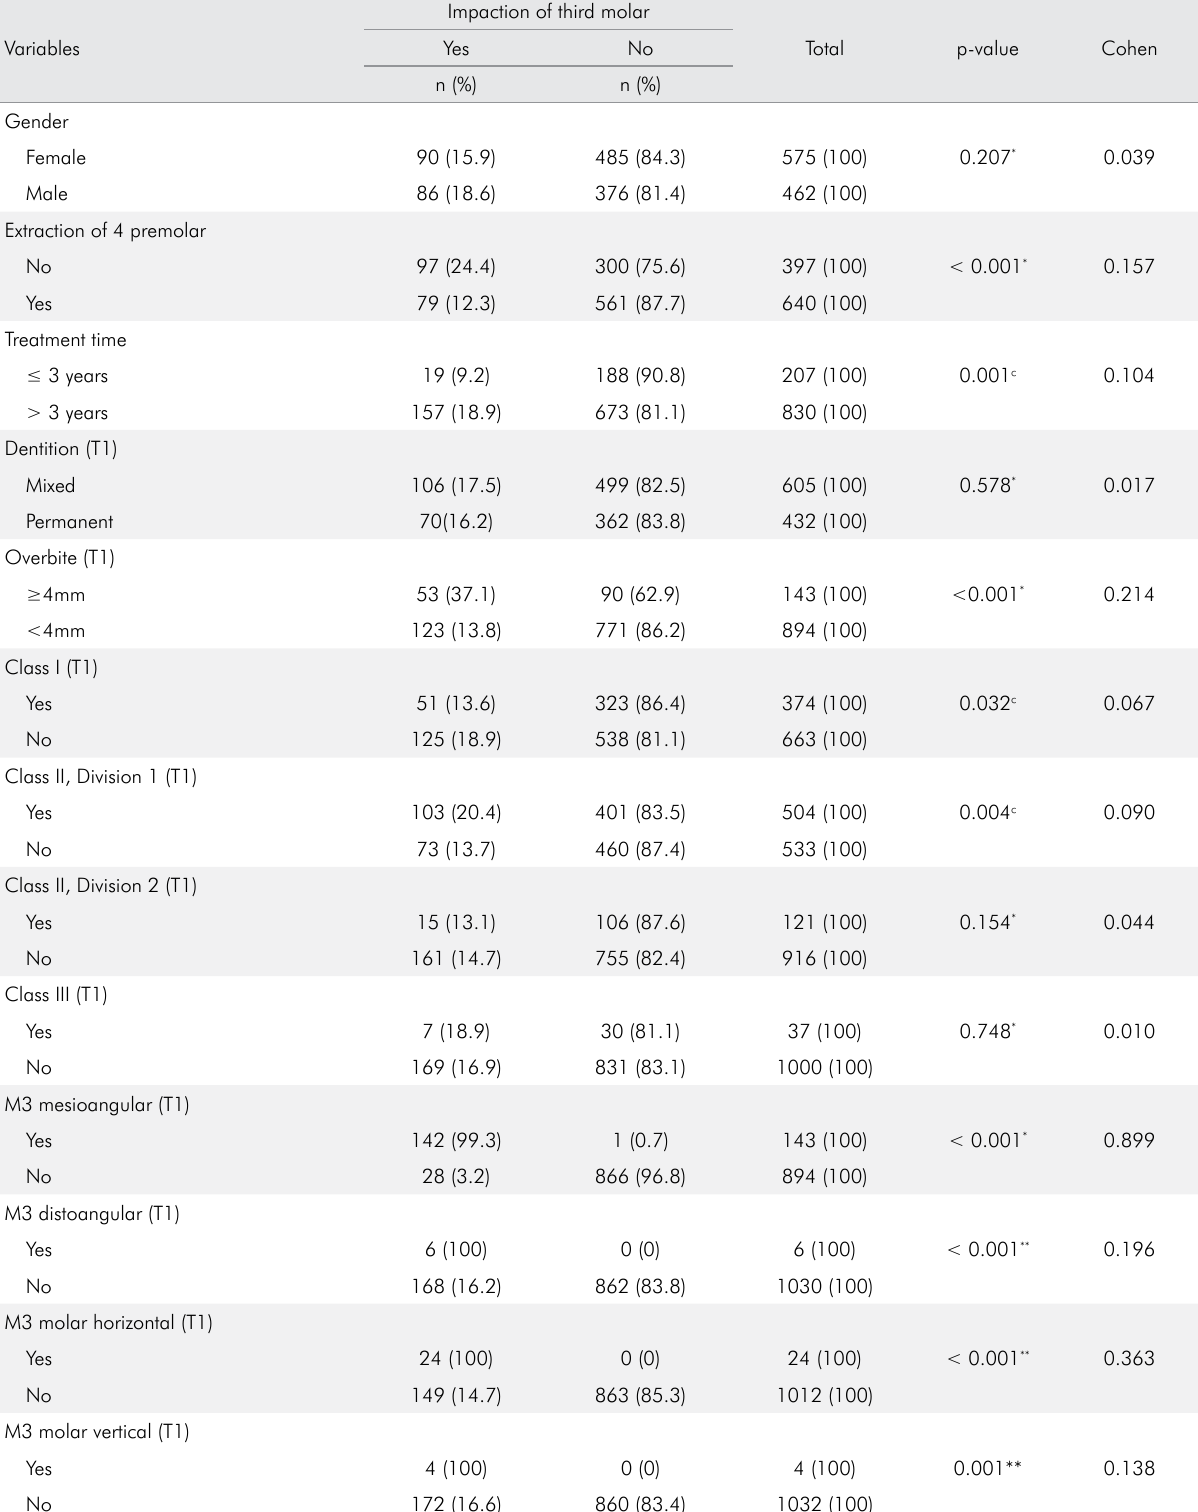
Table 1. Analysis of relationship between impaction of third molar and independent